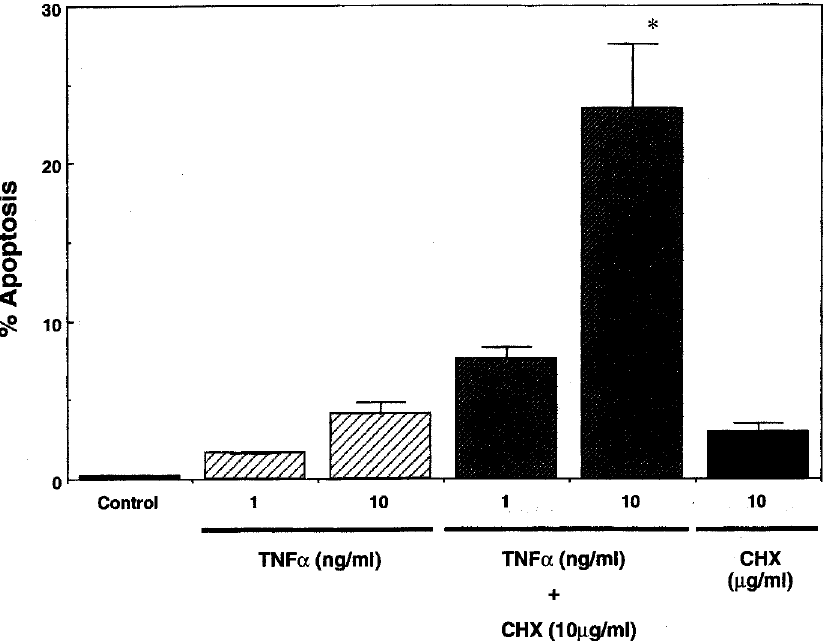
FIG. 1. Apoptosis of endothelial cells treated with TNF a and cycloheximide. Endothelial cell monolayers were treated with 1–10ng/ml TNF a in the presence or absence of cycloheximide (CHX) (10 m g/ml) for 6h. After the incubation treatment, the cells were stained with PI, as described in Materials and methods. The percentage of apoptotic endothelial cells represents the number of apoptotic cells in the counted 100 cells (apoptotic cells + viable cells). The data show the mean±SEM for 10 wells. * P <0.05 versus TNF a -treated group. Each experiment was repeated three times.